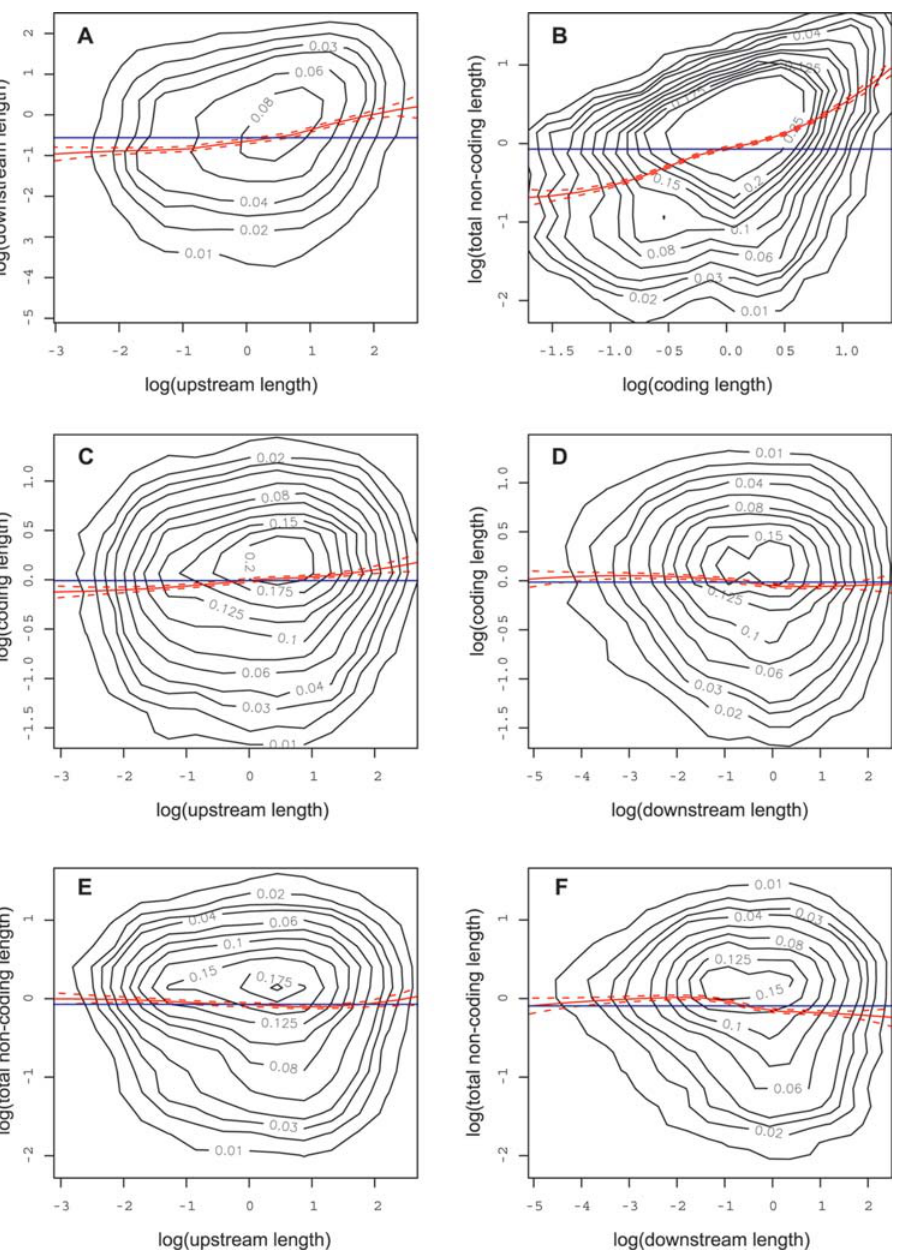
Figure 2. Inter-dependencies between the sequence lengths associated with a gene. Relationships between the natural logarithm of lengths (in kb) of the sequences associated with a gene. For this figure and Figure 3–5, the contours were obtained from a 2 d kernel density estimate. The numbers on the contours show the cumulative density contours (the total probability contained within the contour). The solid red line shows the trend in y axis as a function of x axis obtained via a local linear regression smoother. Dashed red lines show 95% confidence intervals, blue lines show constant mean and axes are scaled to the (0.5%, 0.95%) quantiles of the respective variables.